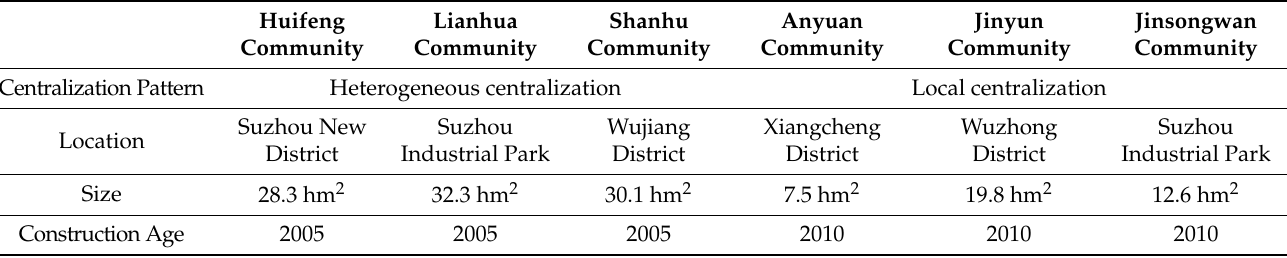
Table 1. Introduction of the communities